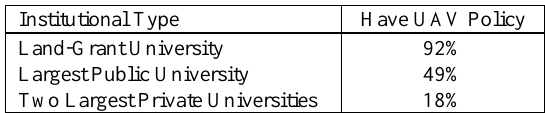
Table 1. Type of institutions with UAV policies